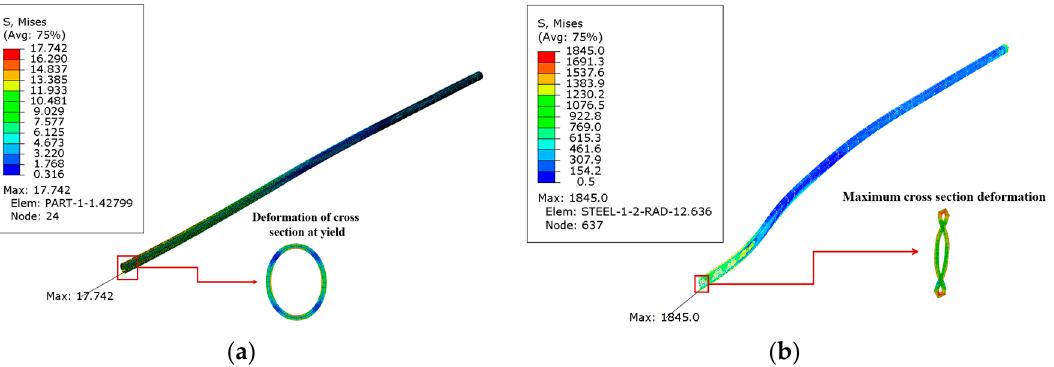
Figure 8. Mises stress distribution of polyethylene and steel wires in the SWW-RTP: ( a ) Mises stress distribution of the SWW-RTP when the HDPE begins to yield; ( b ) Mises stress distribution of the SWW-RTP when the steel wire’s ultimate strength is